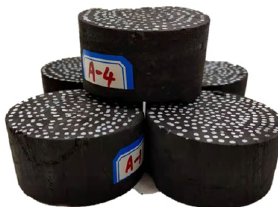
Figure 1. Typical coal